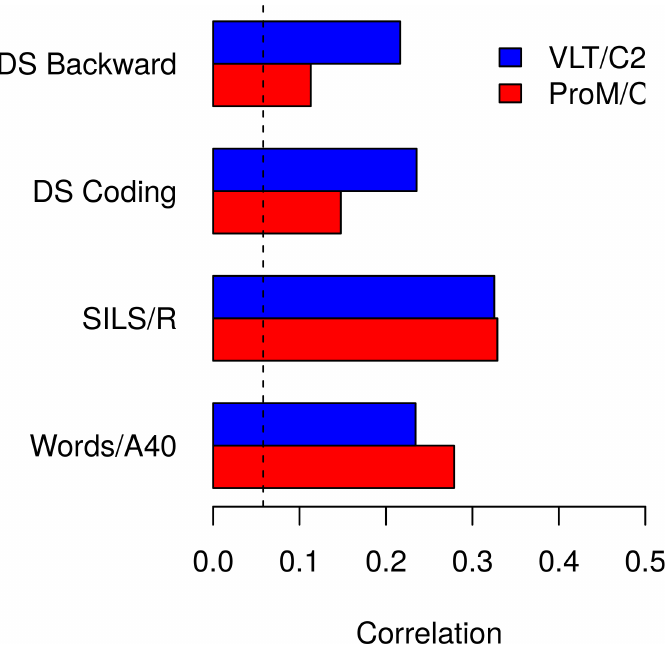
Fig 2. Correlations between ProM and RetM with intelligence, processing speed, and working memory. ProM versus RetM correlations with crystallized and fluid intelligence were comparable. In contrast, correlations with processing speed and working memory were smaller for ProM versus